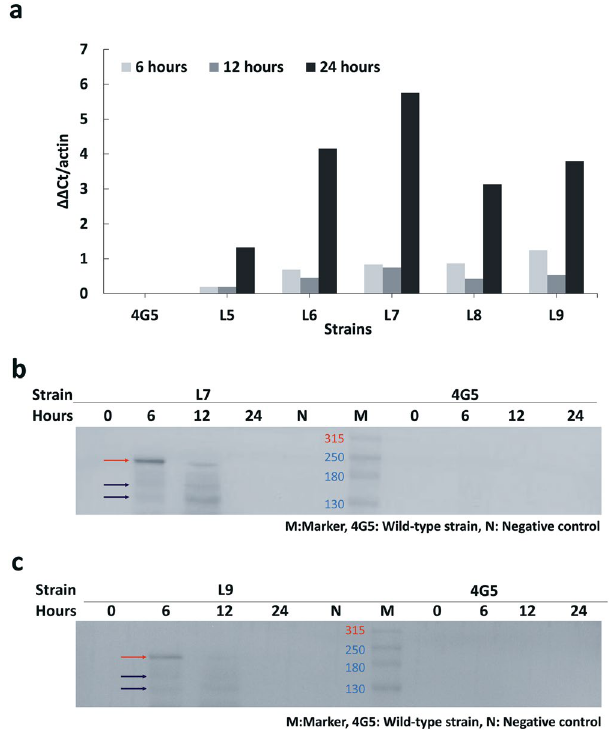
Figure 2. Cas9 gene expression at different culturing times by qRT-PCR and western blot. ( a ) Cas9 gene expression levels at different culturing times measured by qRT-PCR assays. The colors represent: gray for six hours; dark gray for 12 hours; and black for 24 hours. The strain with the highest Cas9 gene expression at 6 hours was L9, while the strain with the highest Cas9 gene expression at 12 hours and 24 hours was L7. ( b ) Expression profiles of Cas9 protein in L7 at different culturing times. The red and blue arrow indicates the Cas9 protein. ( c ) Expression profiles of Cas9 protein in strain L9 at different culturing times. The red ( > 180 kDa) and blue ( < 180 kDa) arrows indicate the Cas9 proteins confirmed by the LC-nESI-Q Exactive mass spectrometer (Supplementary Fig. S7).